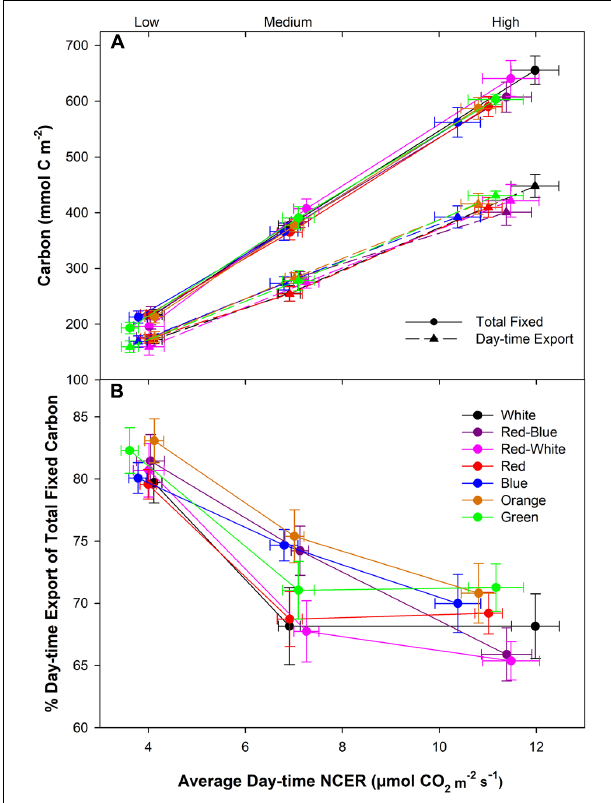
FIGURE 5 | Total carbon fixed and exported during the photoperiod under low, medium, and high photosynthetic rates from leaves that were illuminated by various LED systems (A) . B illustrates the relationship between export and photosynthesis during the day-time under different LED treatments. Relative export during the day-time was expressed as the percentage of the total fixed